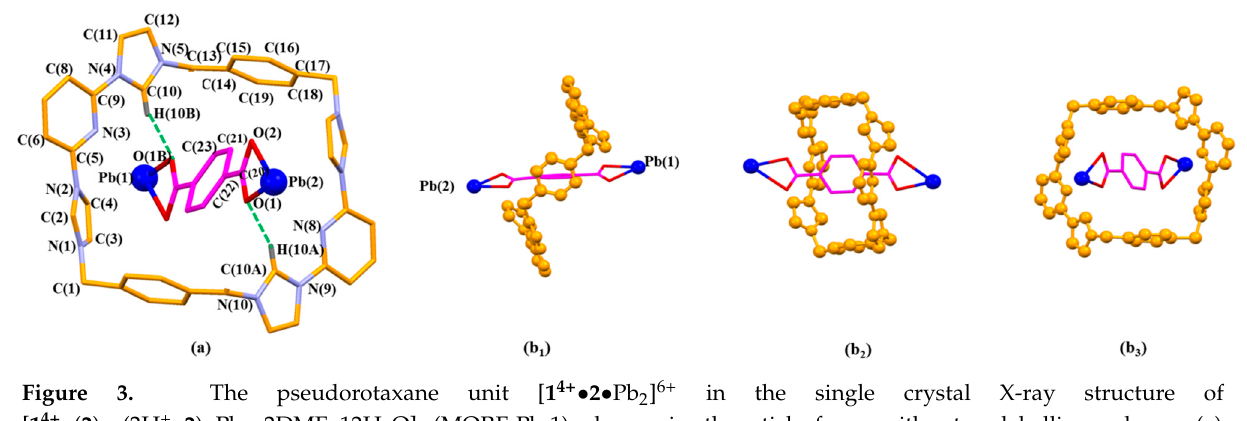
Figure 3. The pseudorotaxane unit [ 1 4+ • 2 •Pb 2 ] 6+ in the single crystal X-ray structure of [ 1 4+ •( 2 ) 4 •(2H + • 2 )•Pb 2 •2DMF•12H 2 O] (MORF-Pb-1) shown in the stick form with atom-labelling scheme ( a ). Top ( b 1 ), side ( b 2 ), and front ( b 3 ) views of the [ 1 4+ • 2 •Pb 2 ] 6+ pseudorotaxane structure are shown. Selected interatomic distances [Å] for possible C-H… π interactions: C(21)…C(15) 3.79(0), C(21)…C(16) 3.75(8), C(23)…C(14) 3.63(0), C(23)…C(15) 3.64(6); Possible intermolecular hydrogen bonding interactions are evidenced by the following selected interatomic distances [Å]: C(10A)…O(1) 3.10(2), C(10)…O(1B) 3.10(2) and selected interatomic angles: C(10A)-H(10A)…O(1) 148.0(2)°, C(10)-H(10B)…O(1B) 148.0(2)°. The asymmetric monomer unit of MORF-Pb-1 contains one molecule of macrocycle 1 4+ , three Pb 2+ , three PTADA ligands in different local chemical environments, and two coordinated H 2 O solvent moieties. In particular, one molecule of free p -phthalic acid molecule is located in the channels of MORF-Pb-1 (Figure 4). Monomer units can further construct a chain-shaped 1D polyrotaxane structure that extends infinitely in the direction of the crystallographic a -axis through the complexation between Pb(1) and 2 (highlighted with dark magenta colour) (Figure 5).